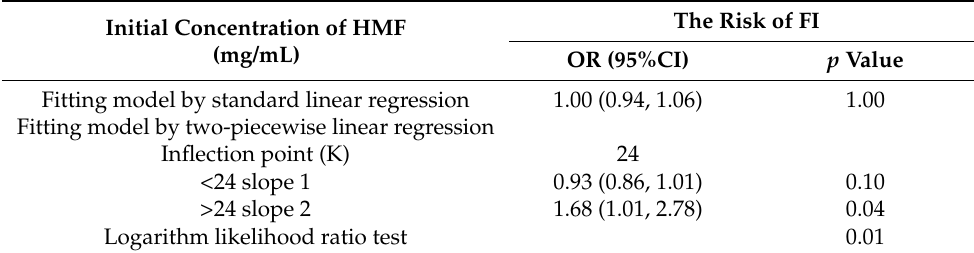
Table 7. Threshold effect analysis of the relationship between initial concentration of HMF and the risk of FI. Dates, 2015–2018.